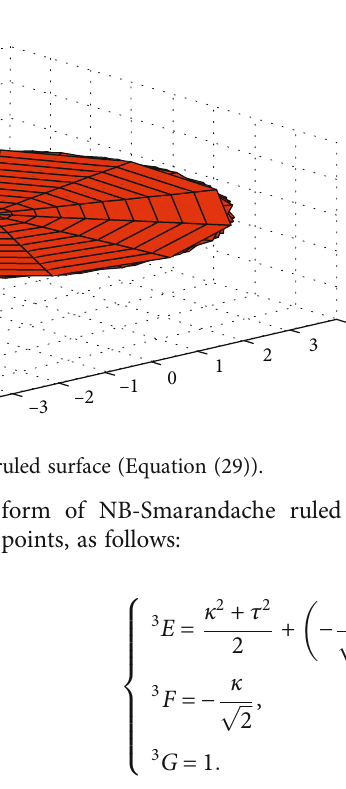
Figure 1: The TN-Smarandache ruled surface (Equation (21)).